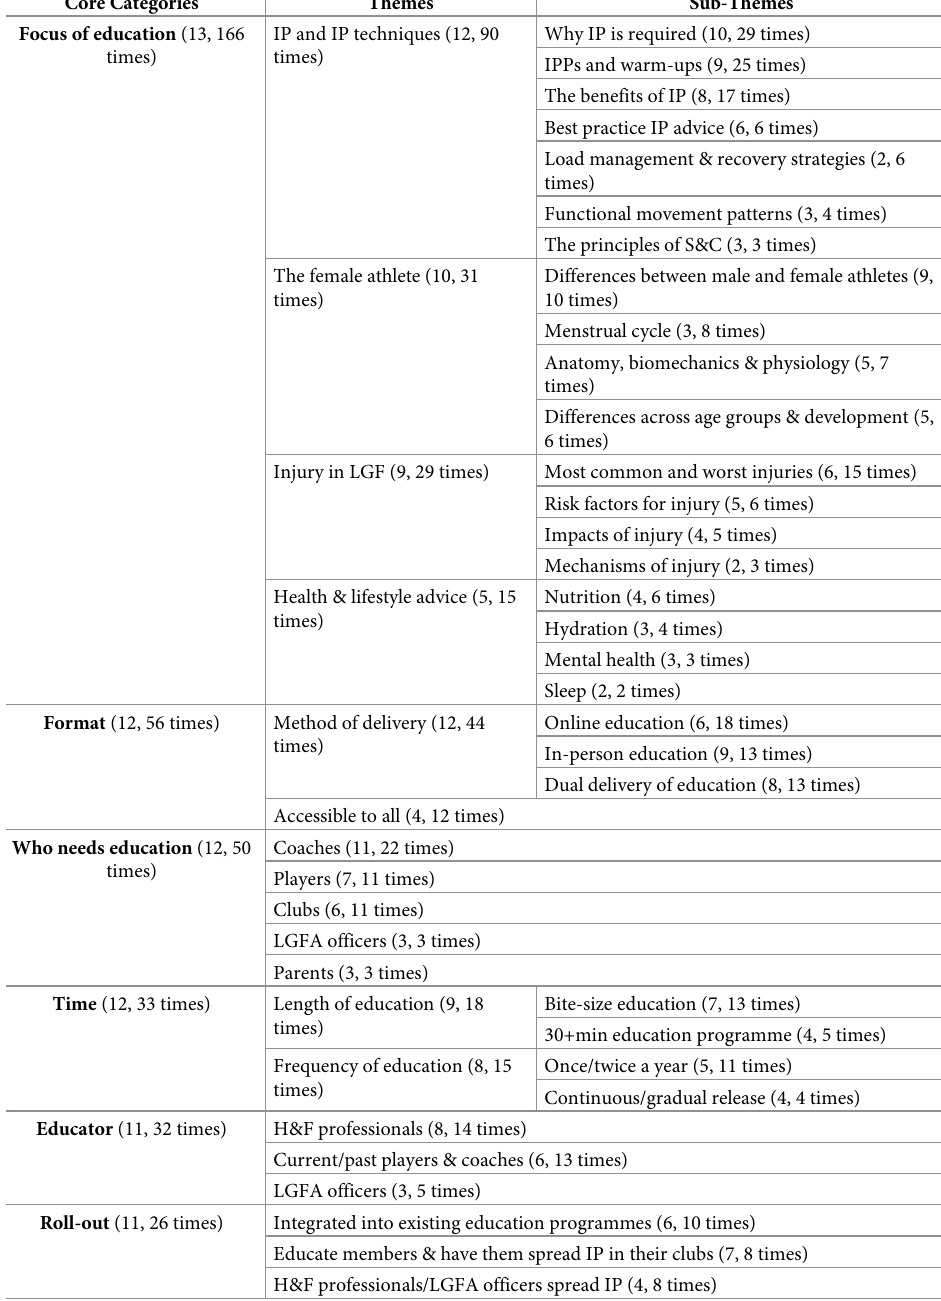
Table 3. Core categories, themes, and sub-themes surrounding coaches’ injury prevention education preferences (no. of coaches, no. of